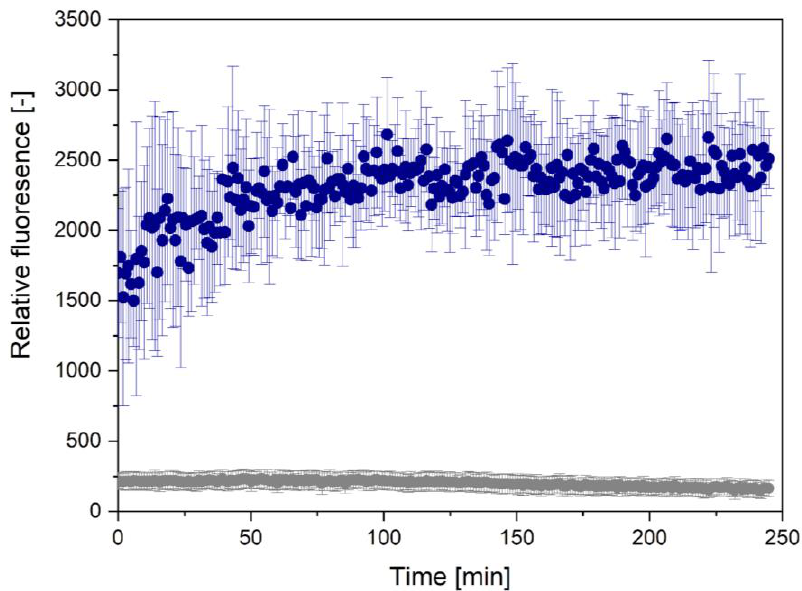
Figure 8. Time-dependent ThT fluorescence curves for R4 fragments. Here, grey dots represent E. coli , blue ones S. enterica . Peptide concentration was 500 µM.